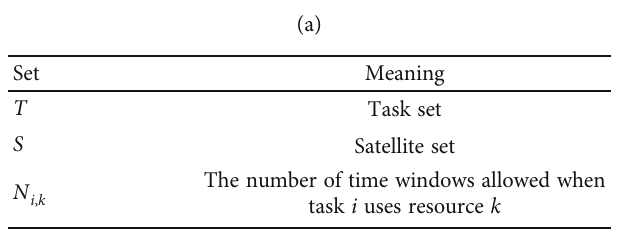
Table 1: Temperature and wildlife count in the three areas covered by the